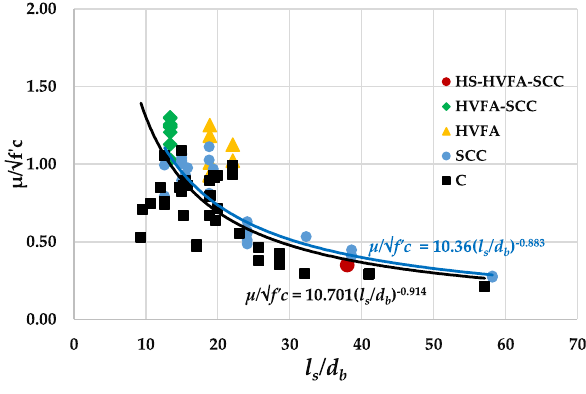
Fig. 8 Comparison of beam splice length of HS-HVFA-SCC with other concrete